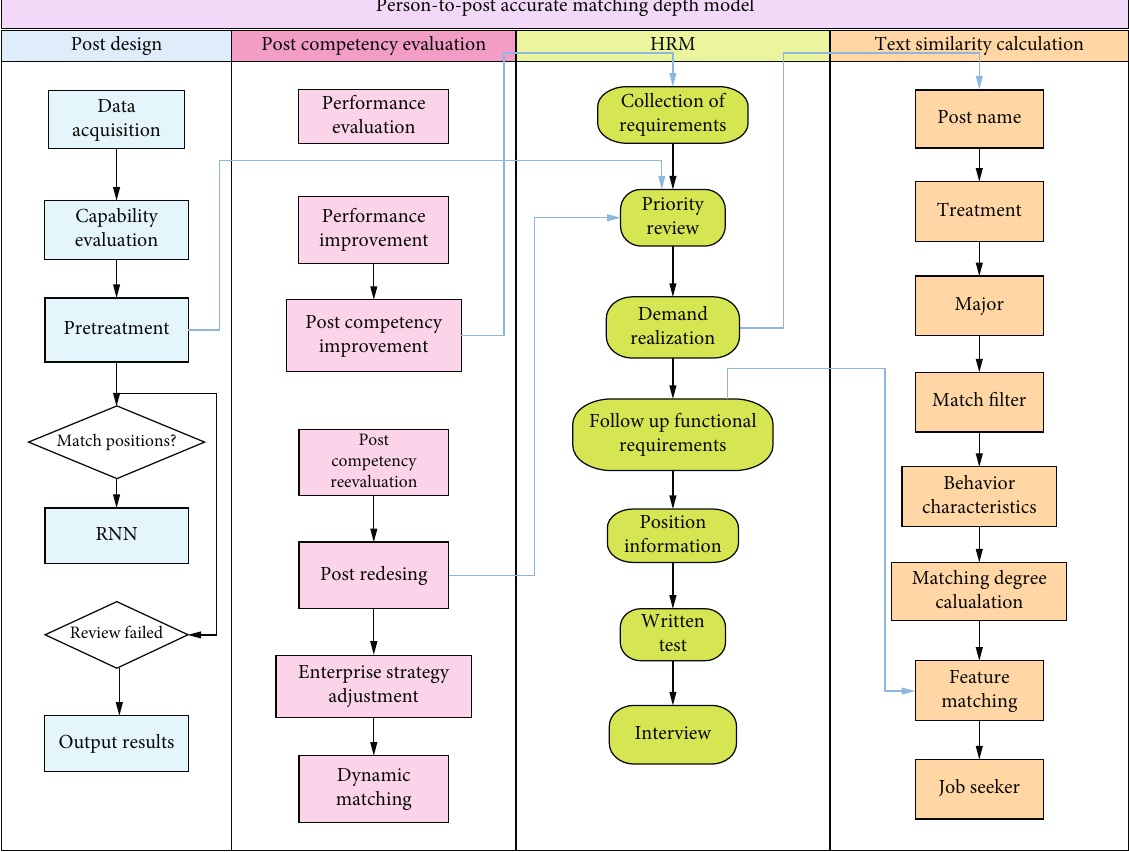
Figure 3: Depth model of precise matching between people and posts combined with ability